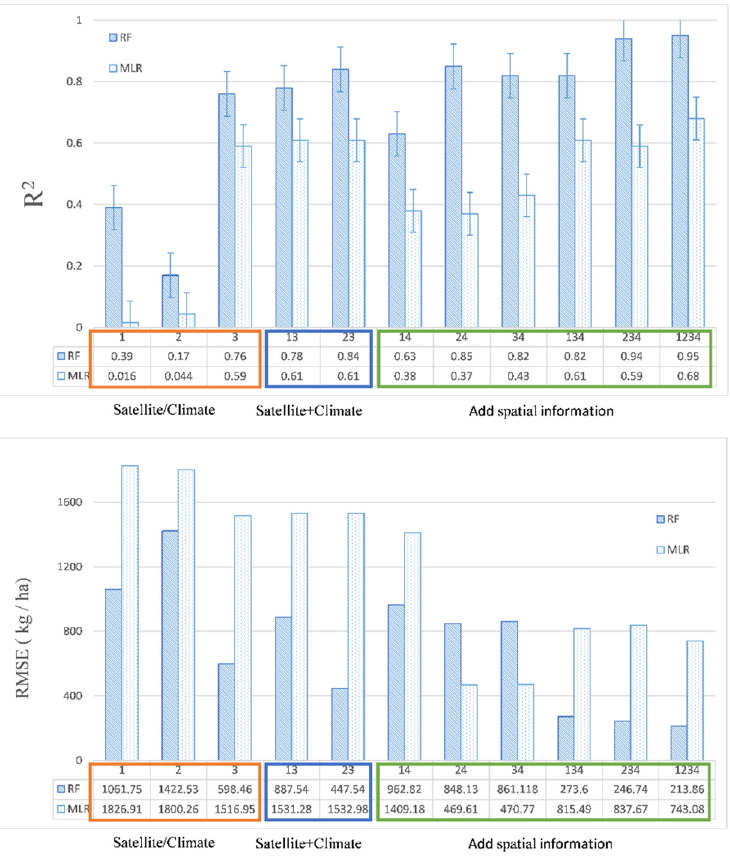
Figure 4. The model performance (predicted R 2 , RMSE) of two methods using different combinations of inputs for the whole growing season, each number representing a different input combination, which can be expressed as 1: SIF, 2: EVI, 3: Climate, 4: Location, 13: SIF + Climate, 23: EVI + Climate, 14: SIF + Location, 24: EVI + Location, 34: Climate + Location, 134: SIF + Climate + Location, 234: EVI+Climate+Location, 1234: SIF+EVI+Climate+Location.